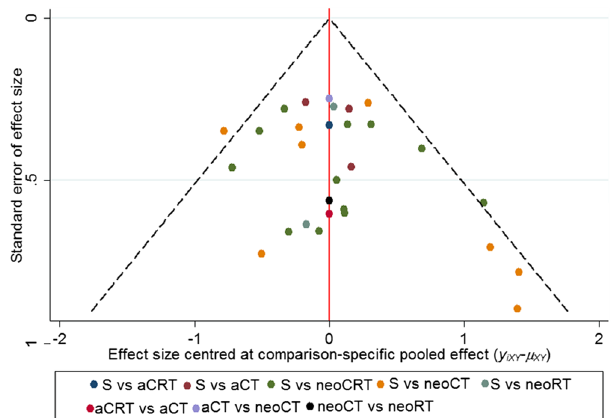
Figure 6. Funnel plot for risk of publication